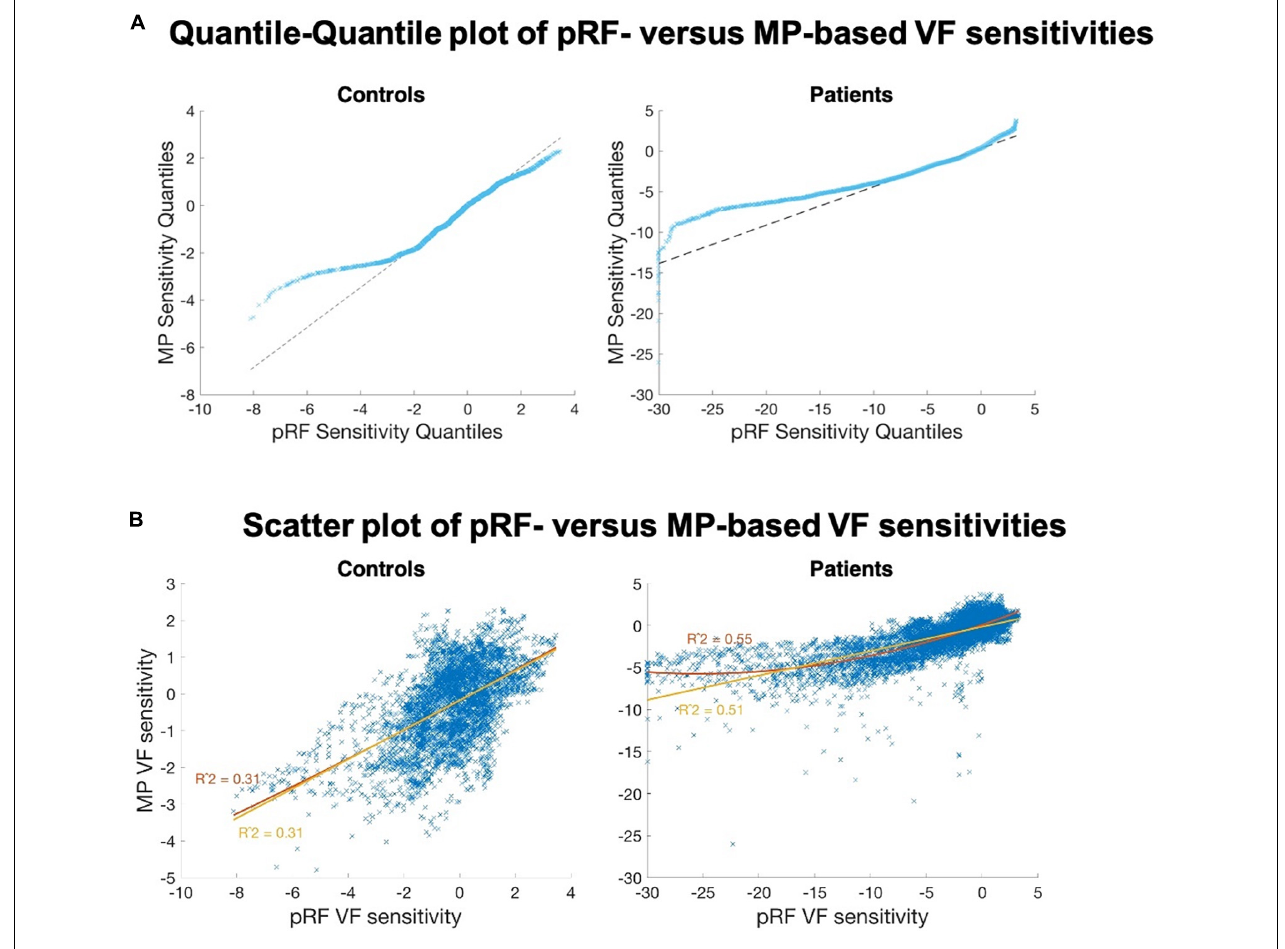
FIGURE 8 | Comparison of the VF sensitivities as measured with the two fMRI approaches. (A) Quantile-Quantile plot of the VF sensitivities of pRF versus MP, for controls (left) and patients (right). Strong deviations from the linear reference line indicate that both distributions do not share the same distribution. For the negative estimates, in particular below < 2 dB (controls) and < 10 dB (patients), we found fewer negative estimates for MP than for pRF. (B) PRF VF sensitivities plotted against the MP VF sensitivities, for the controls (left) and the patients (right). The control data are linearly correlated. The patient data revealed a non-linear ( R 2 = 0.55, red curve) rather than a linear ( R 2 = 0.51, yellow line) relationship between the two VF sensitivity